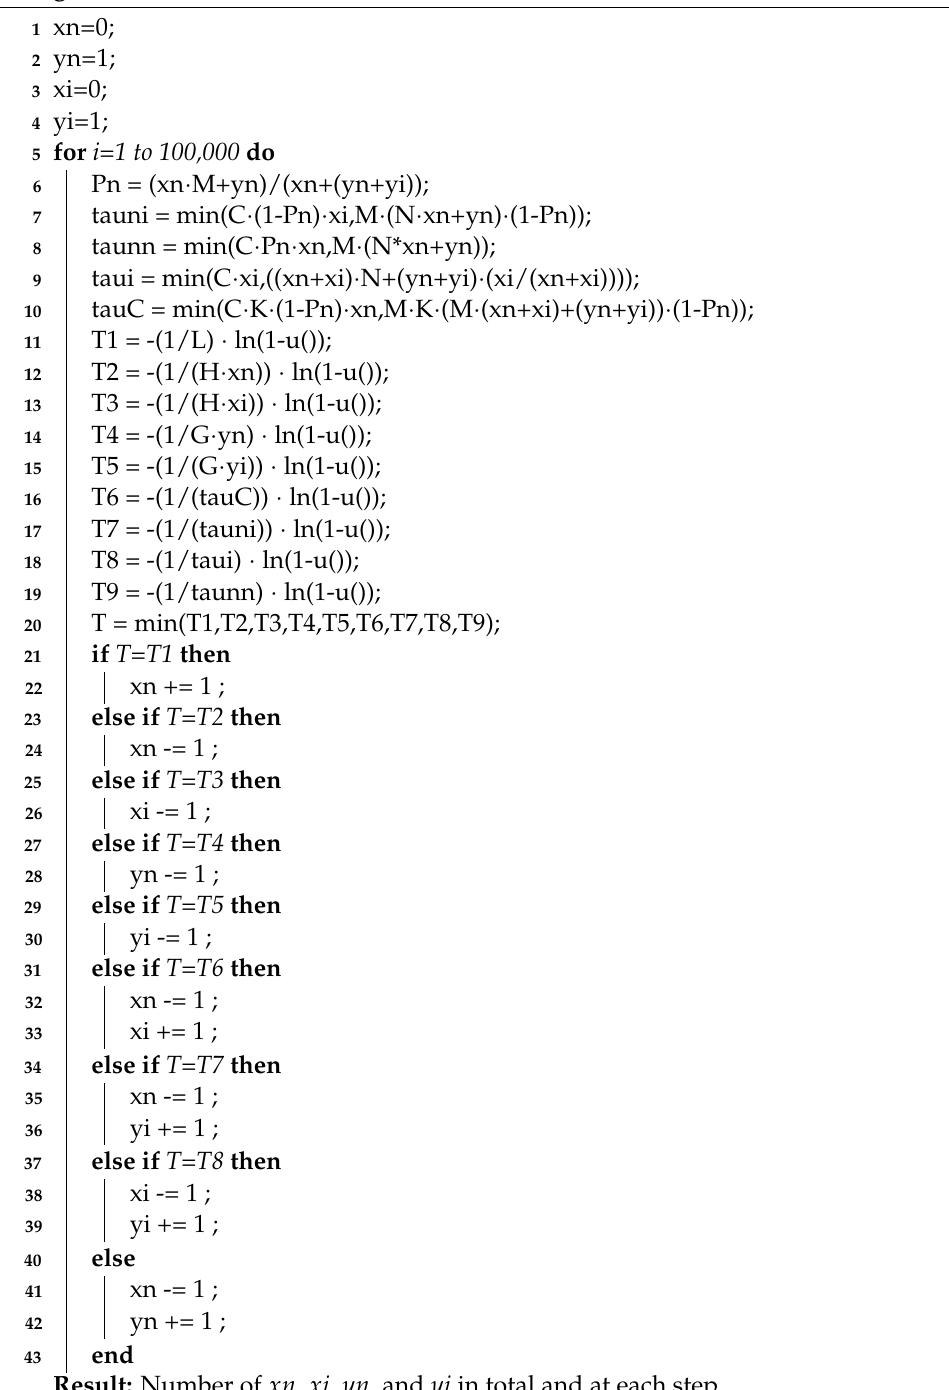
Algorithm A2: Chain with infected